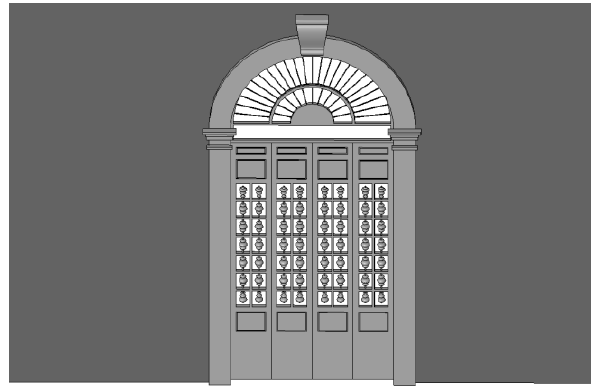
Figure 8. Naples Federico II building. 3D model of the